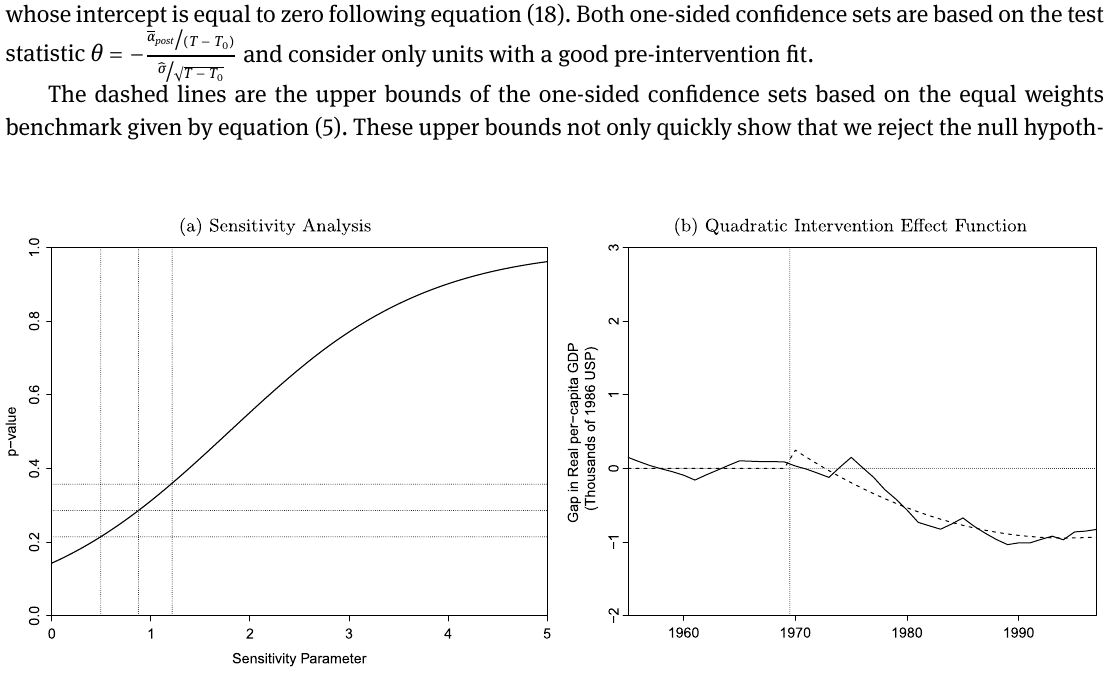
Figure 2: Sensitivity Analysis and Quadratic Intervention Effect. Note: In the left panel, the black line denotes the estimated p- value for each value of the sensitivity parameter ϕ ∈ ℝ + using only units with a good pre-intervention fit, while the horizontal dotted lines denote the p-values of 3 ⁄ 14 , 4 ⁄ 14 and 5 ⁄ 14 . In the right panel, the black line show the estimated impact of ETA’s terror- ism on the Basque Country’s economy, while the dashed line shows the quadratic function that best approximates this